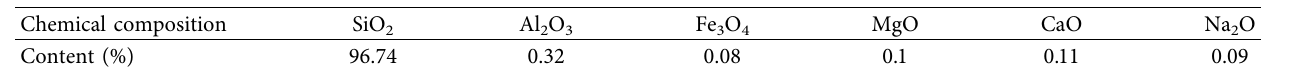
Table 2: Chemical composition of silica